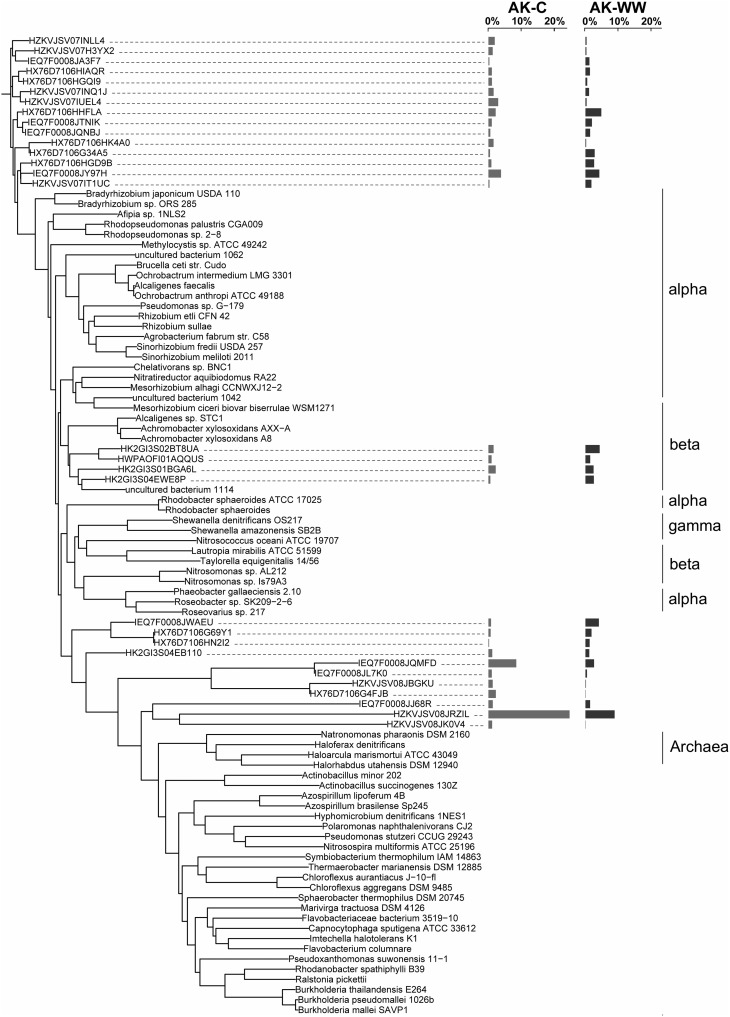
NirK neighbor-joining tree based on amino acid sequences showing the most abundant 33 OTU representative sequences from Alaska control (AK-C) and warming (AK-WW) with reference sequences. The OTUs shown contain 78.0% of sequences in AK-C and 72.0% of the sequences in AK-WW. The average relative abundances are represented by bar graphs to the right of the OTU. The first column corresponds to AK-C, the second to AK-WW.